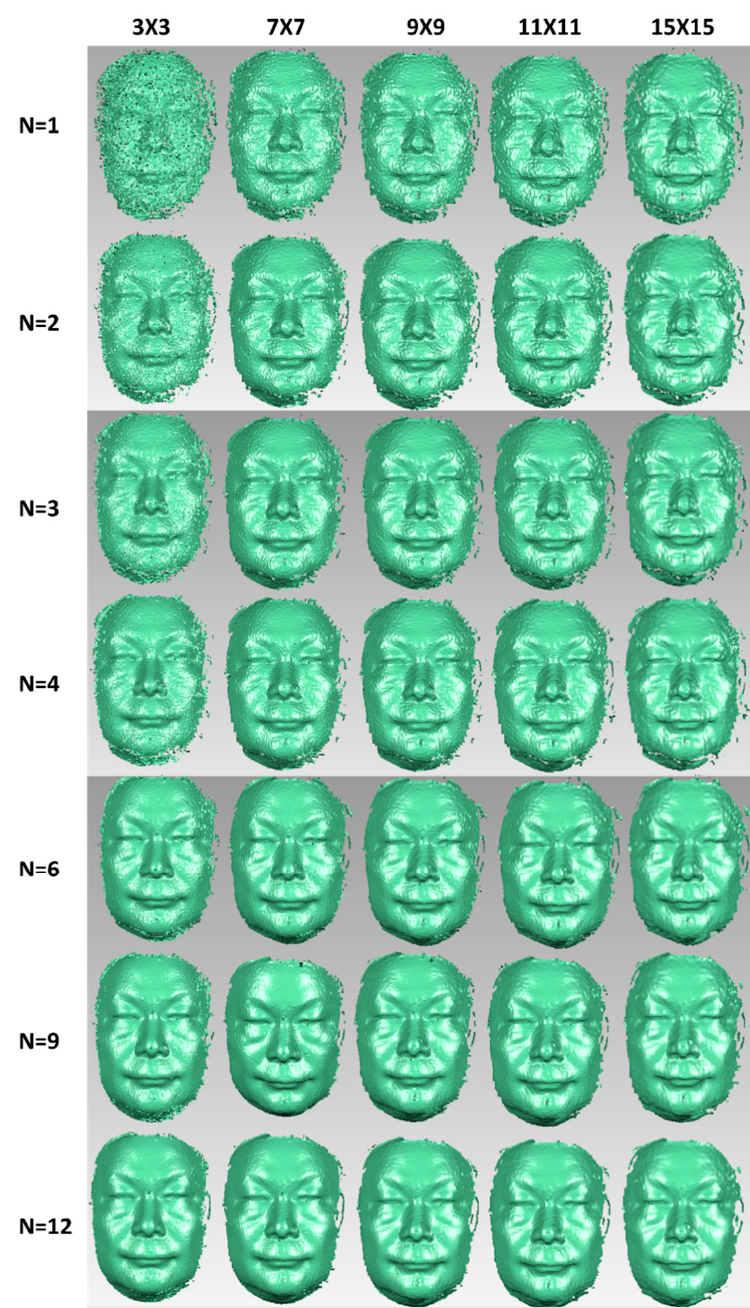
Figure 11. Three-dimensional reconstruction results with a number of stereo image pairs, N, and a w fine matching window, f . The reconstruction accuracy continues to improve as N